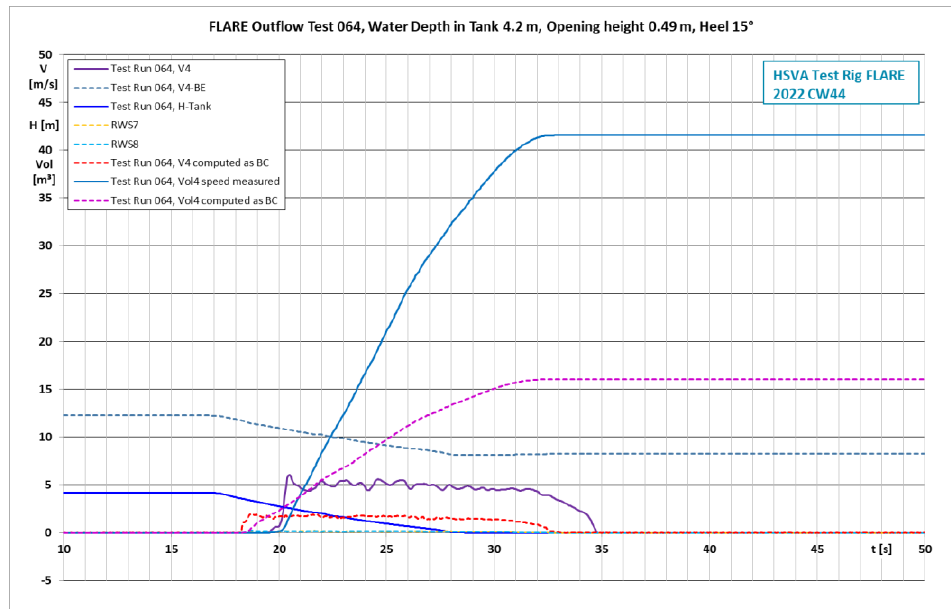
Figure A6. Flow speed V 4 and water elevations RWS7 and RSW8 at the fourth section S 4 for the test run 064. The water discharge volumes Vol 4 based on the flow speed V 4 computed with BE and based on the measured flow speed V 4 are also shown.